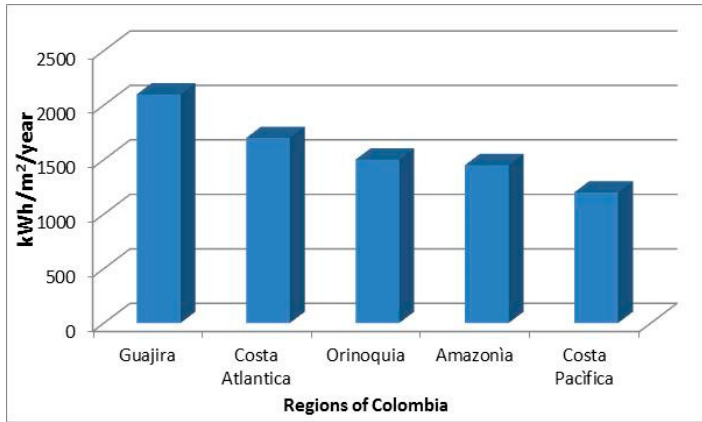
Figure 1. Annual solar radiation for the different strategic regions of Colombia.